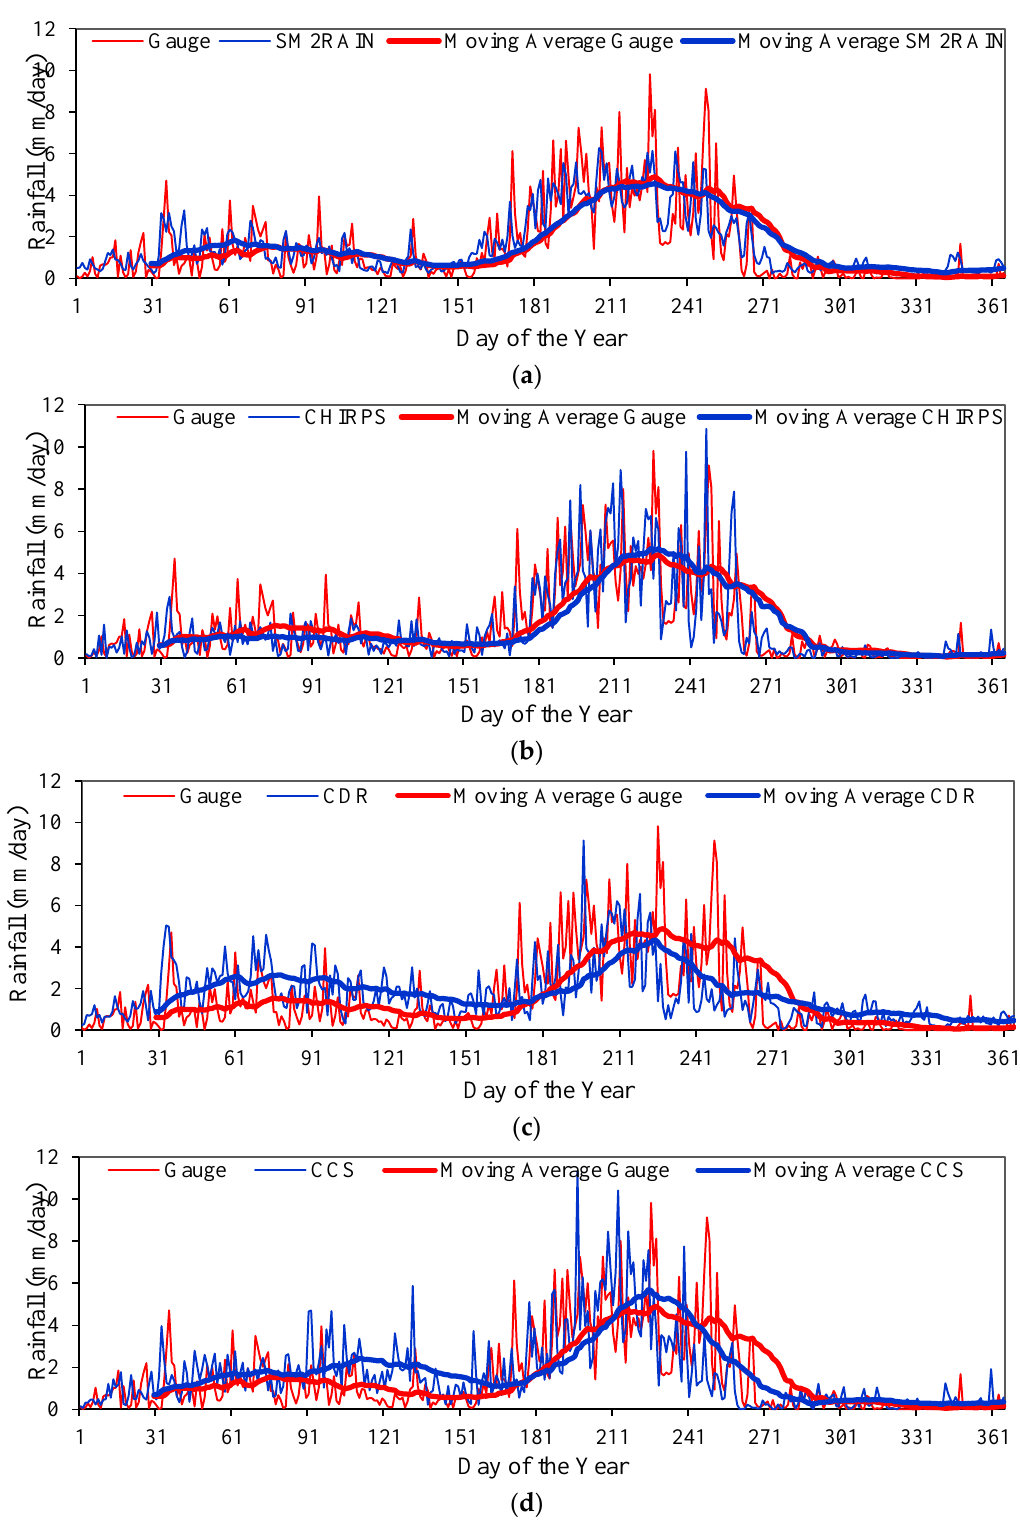
Figure 3. Comparison of the reference (gauge-based) average daily rainfall across the Punjab Province of Pakistan with the average daily rainfall of ( a ) SM2Rain-ASCAT, ( b ) CHIRPS-2.0, ( c ) PERSIANN-CDR, and ( d ) PERSIANN-CCS.